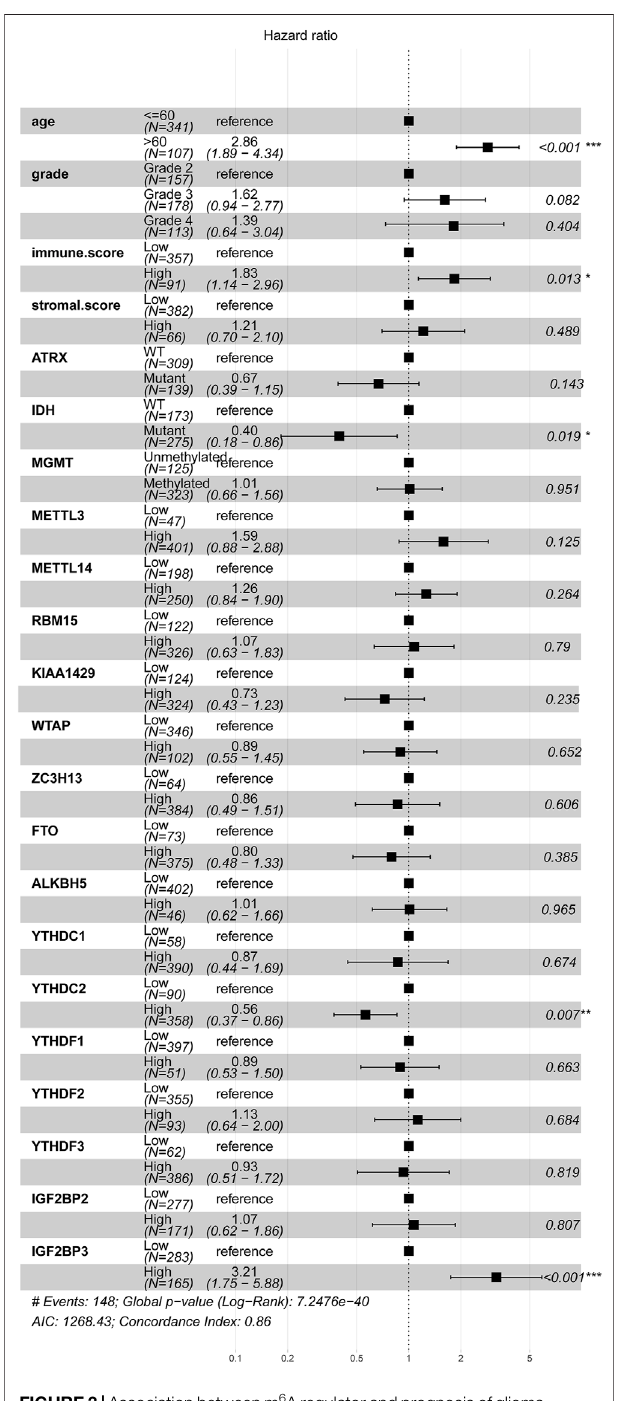
Frontiers in Genetics |